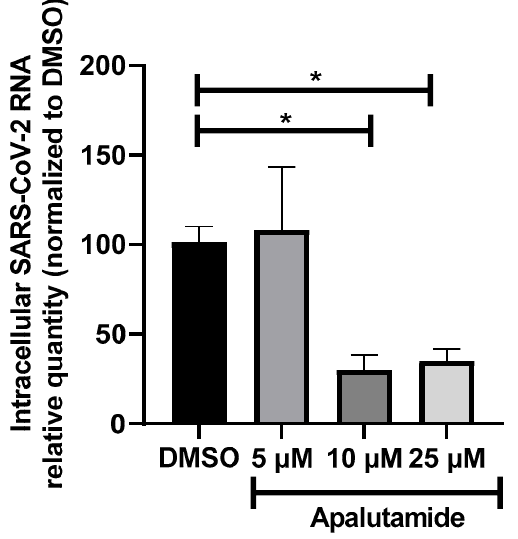
Figure 5. Effect of apalutamide on HNECs infection by SARS-CoV-2. Intracellular RNA was extracted from HNECs 72 h post-infection with SARS-CoV-2 (20 µ L of viral inoculum, 2.04 × 10 5 TCID 50/mL) at the apical pole. HNECS were pre-treated for 48 h before infection with DMSO (control) or apalutamide (5, 10 and 25 µ M) at the basal and apical poles, and the drug was maintained for the entire duration of the experiment. SARS-CoV-2 RNA was quantified by RT-qPCR and the results were normalized to 18S rRNA, then to DMSO (control = 100%). They are expressed as mean ± SEM. (* p < 0.05). For each concentration of apalutamide, HNECs from at least two different patients, in duplicate, were used. Results per HNECs batch are represented in Figure S2.